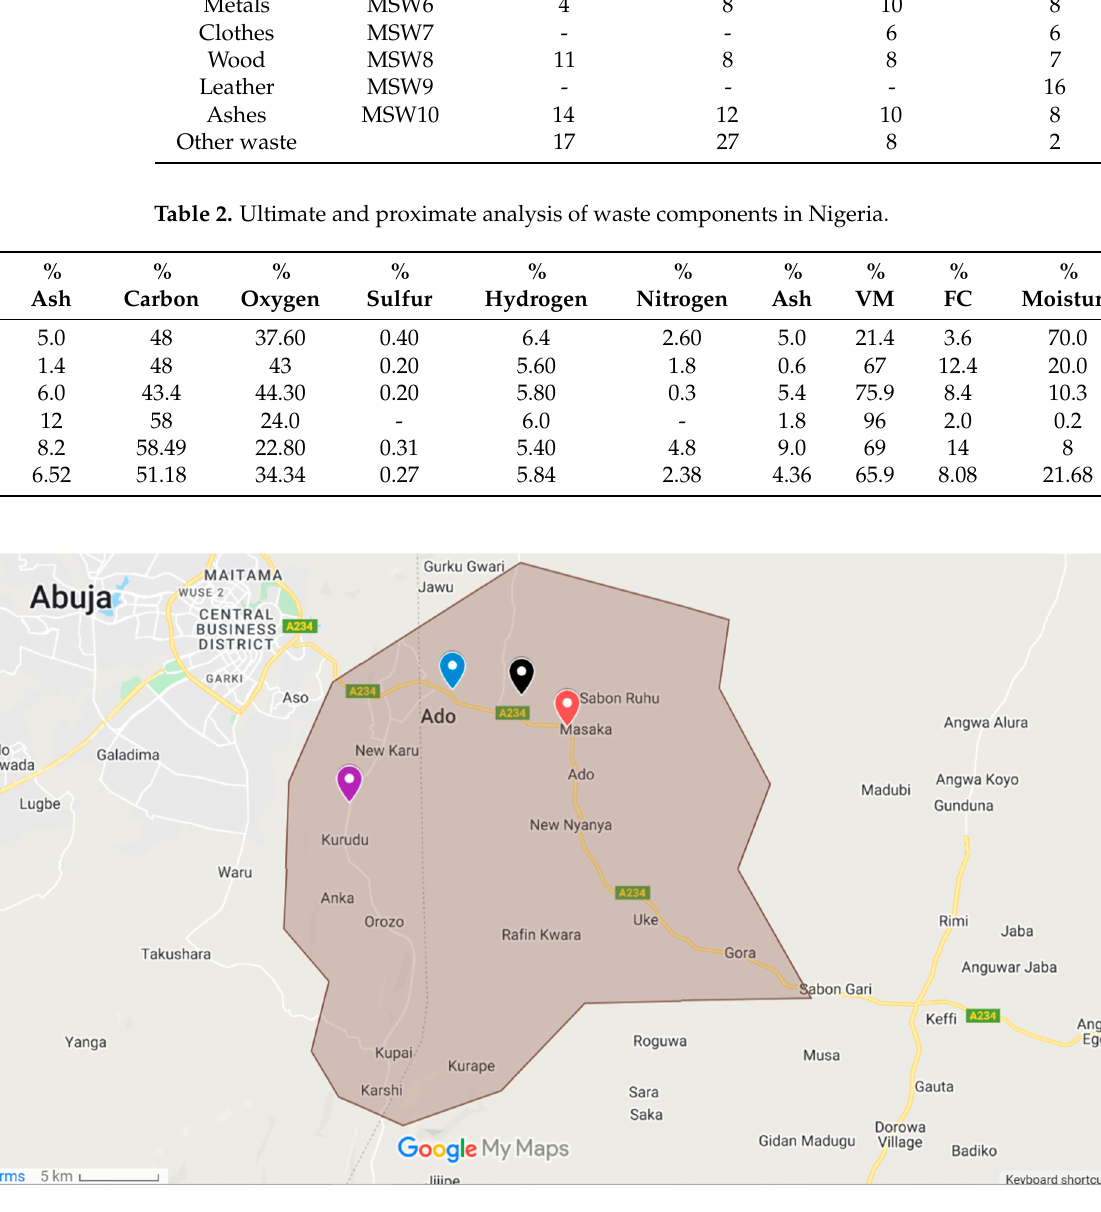
Figure 1. The informal settlements of the Greater Karu Urban Area [55].